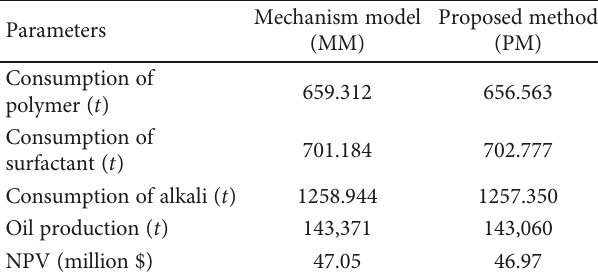
Table 3: Parameter comparison.